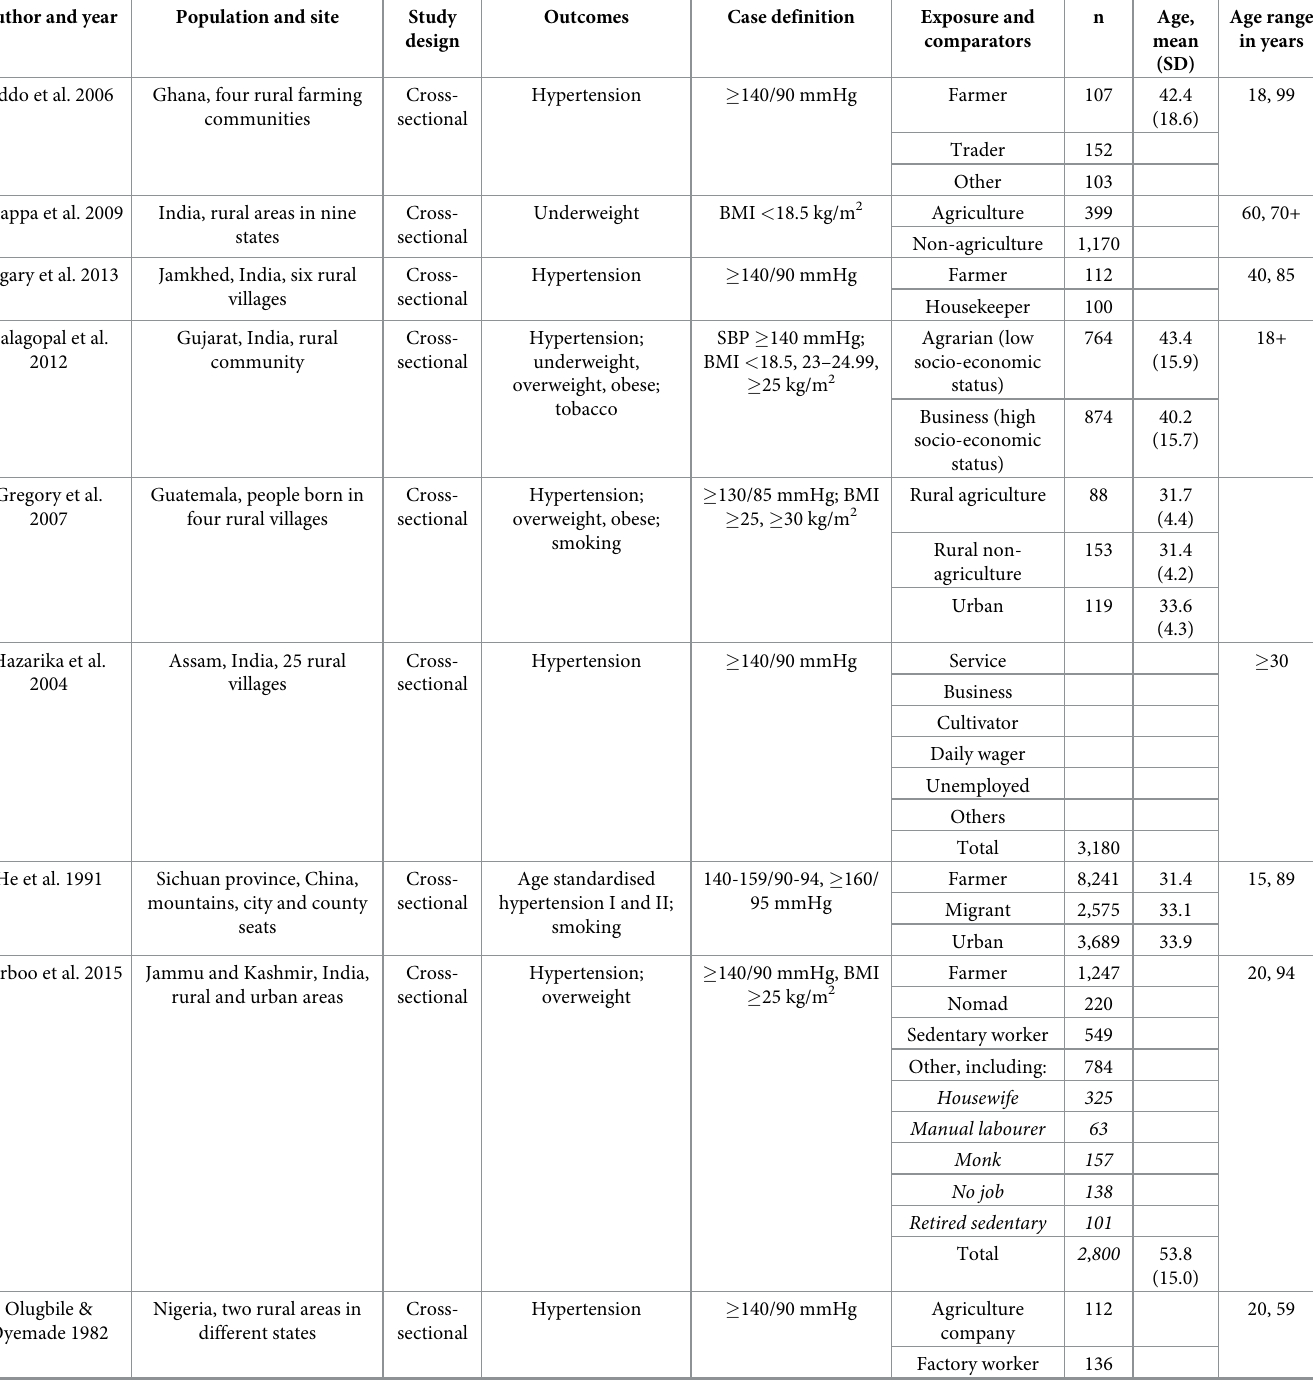
Table 2. Characteristics of included studies from five low- and middle-income countries (n =